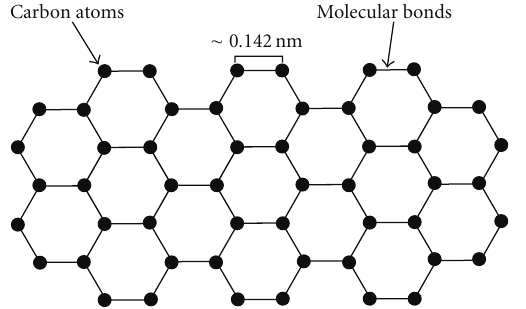
Figure 1: Schematic of the structure of a graphene sheet.